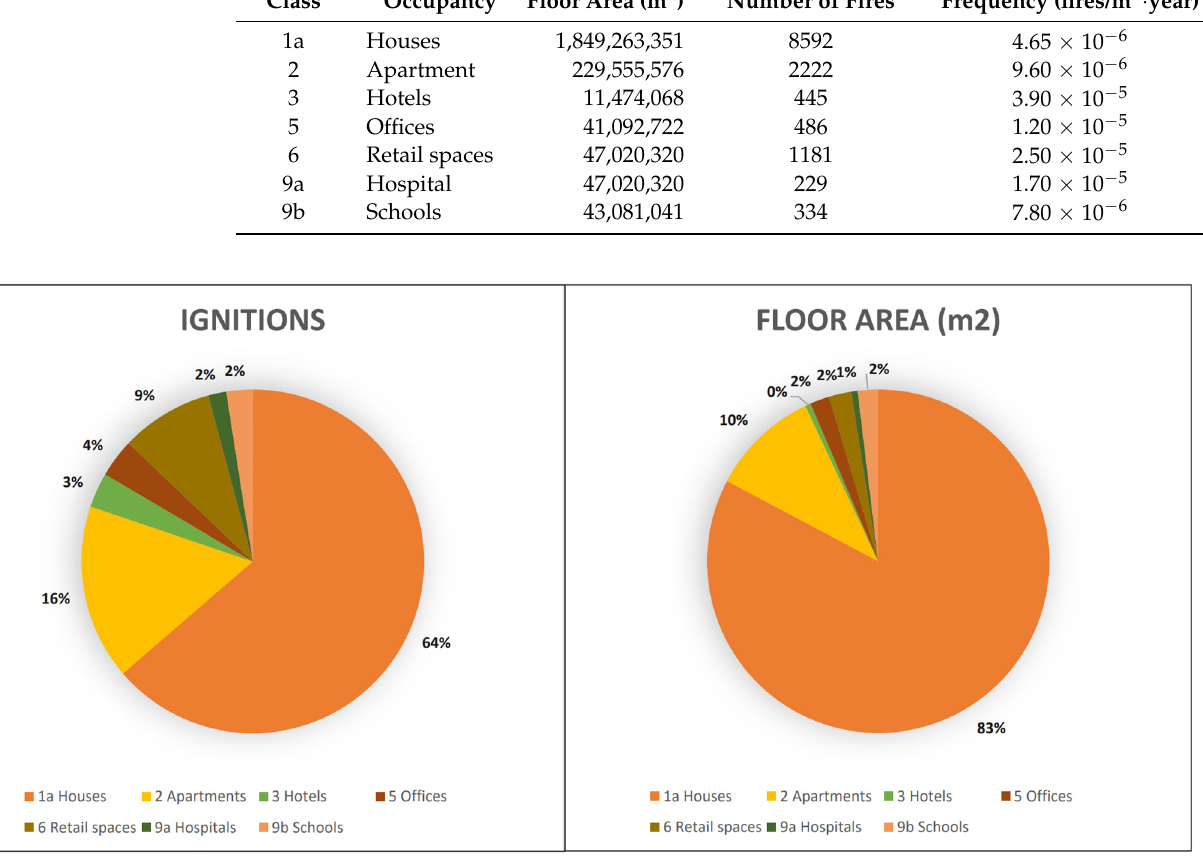
Figure 1. Percentage of ignitions from 2012 to 2019 and floor areas in different building categories in Australia. in